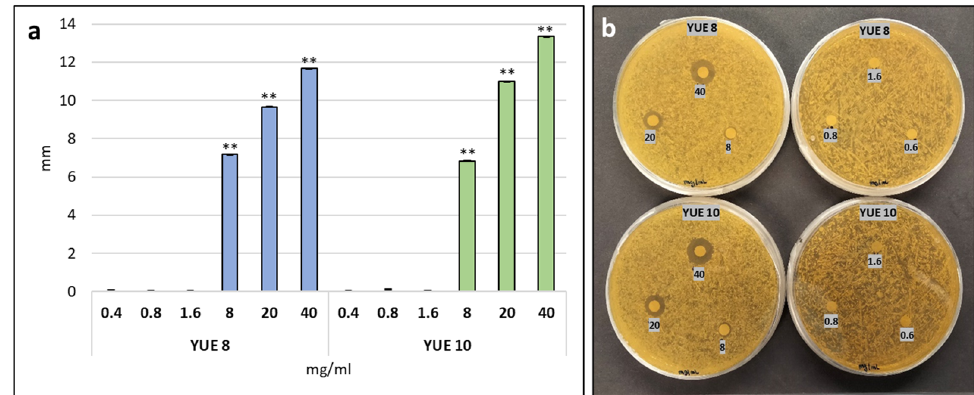
Figure 5. Antifungal effect of yucca extracts on yeast growth. ( a ) Inhibition halo (mm) of yeast BY4741 by YUE 8 (blue) and YUE 10 (green). ( b ) Halo formed around Whatman discs embedded with different concentrations (0.4, 0.8, 1.6, 8, 20 and 40 mg/mL) of YUE 8 and YUE 10. The bars represent the standard error. ** indicates significant differences at p < 0.01 according to the independent sample Student’s t -test.